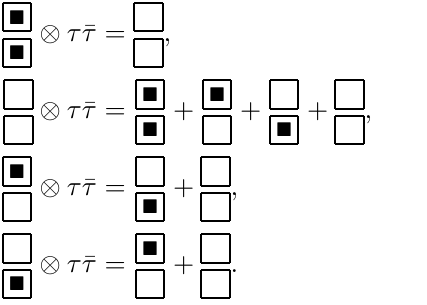
Figure 6 . Identifying the single-particle states of the pseudo-species, as a solution to eq. (4.1). Exclusion Principle 1 leads to the following equations of